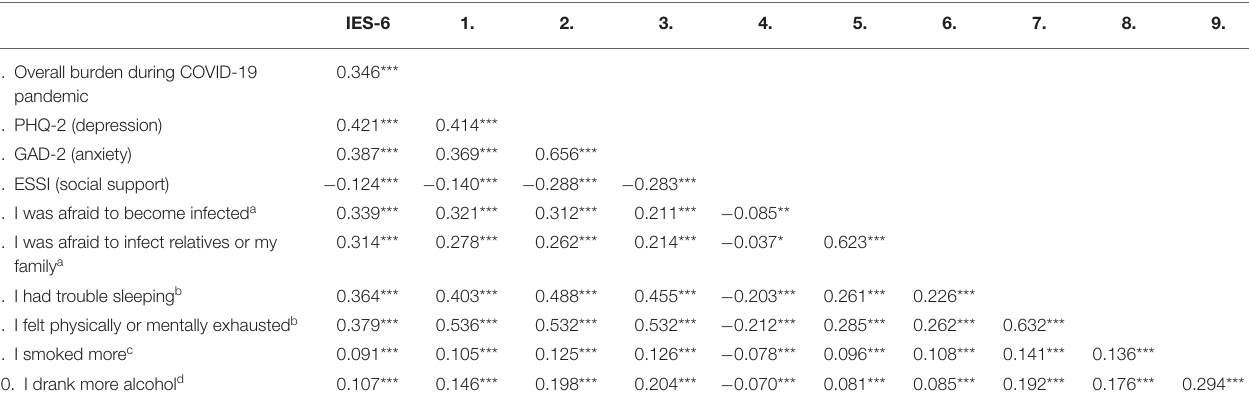
TABLE 3 | Correlations of PTSD symptoms with psychological characteristics among the sample of healthcare workers ( N =